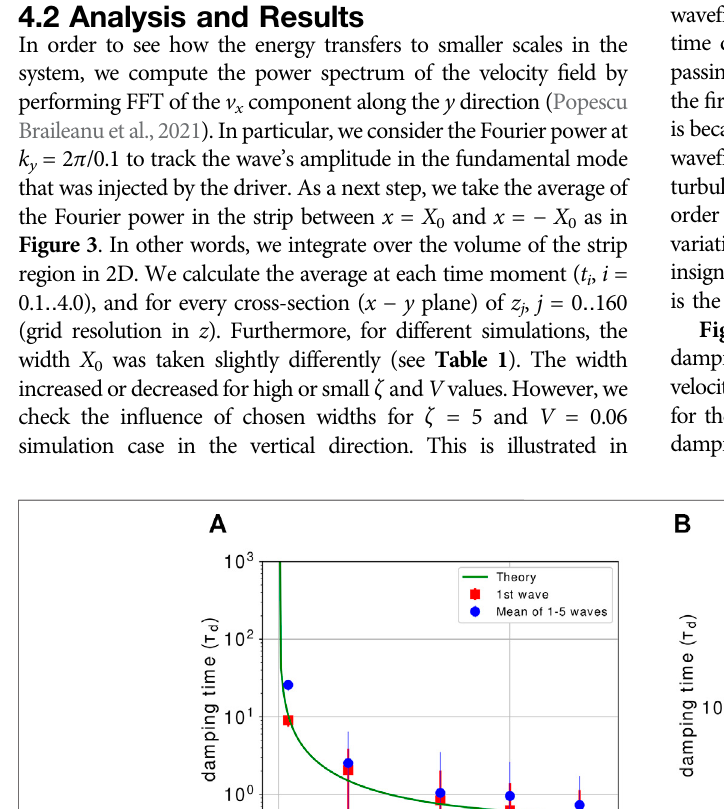
FIGURE 6 | The graph illustrates the power amplitude of the fundamentalwavemodeasafunctionofthe z axis,forthemainsimulation( V (cid:1)